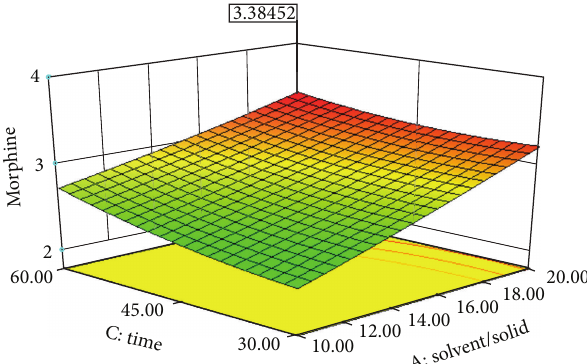
Figure 4: Response surface plot for the EY of poppy straw as a function of solvent pH ( 𝑋2 ) to extraction temperature ( 𝑋4 ).